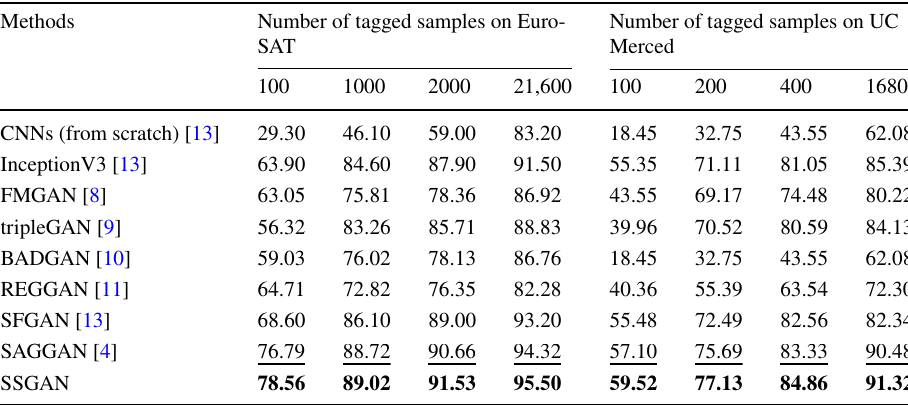
Methods Number of tagged samples on Euro-